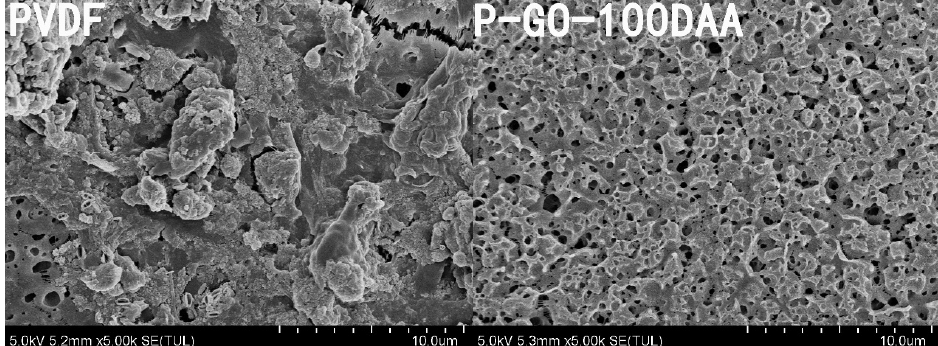
Figure 14. SEM images of the membranes after the three cycles ultrafiltration experiment.